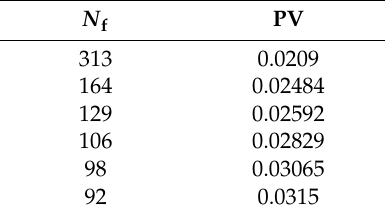
Table 5. Statistical Results of N f and plateau value (PV).